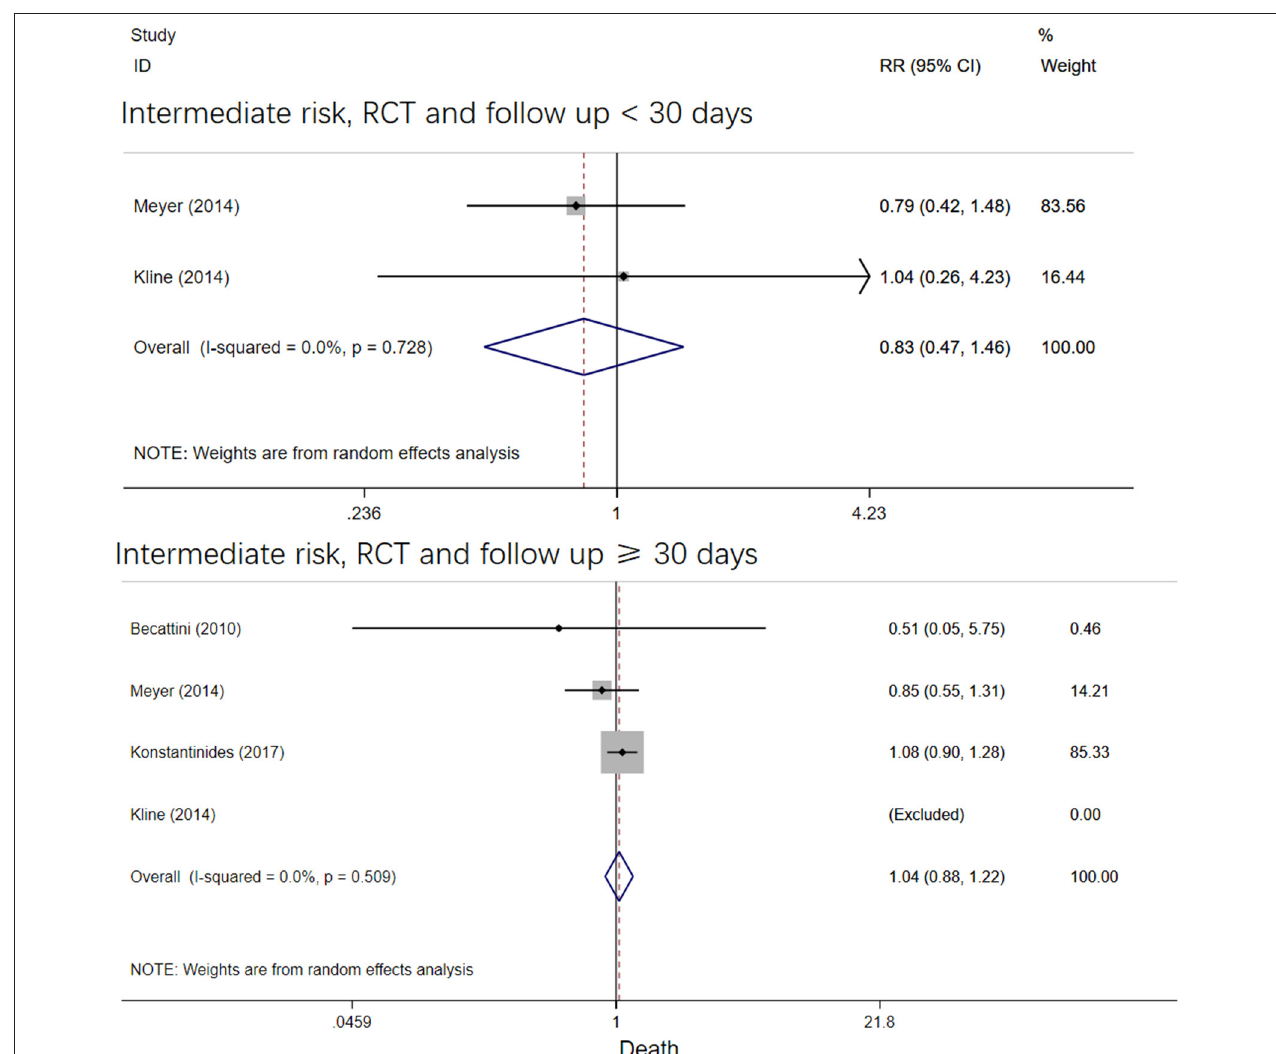
FIGURE 2 | Forest plots of tenecteplase vs. anticoagulation treatment grouped by all-cause mortality and duration of follow-up ( < 30 days or ≥ 30 days) for patients with intermediate-risk